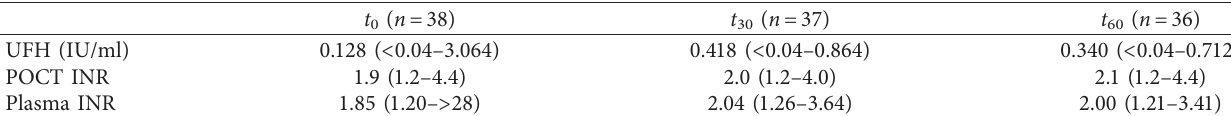
0 , t 30 , and t 60 with minimum and maximum (between